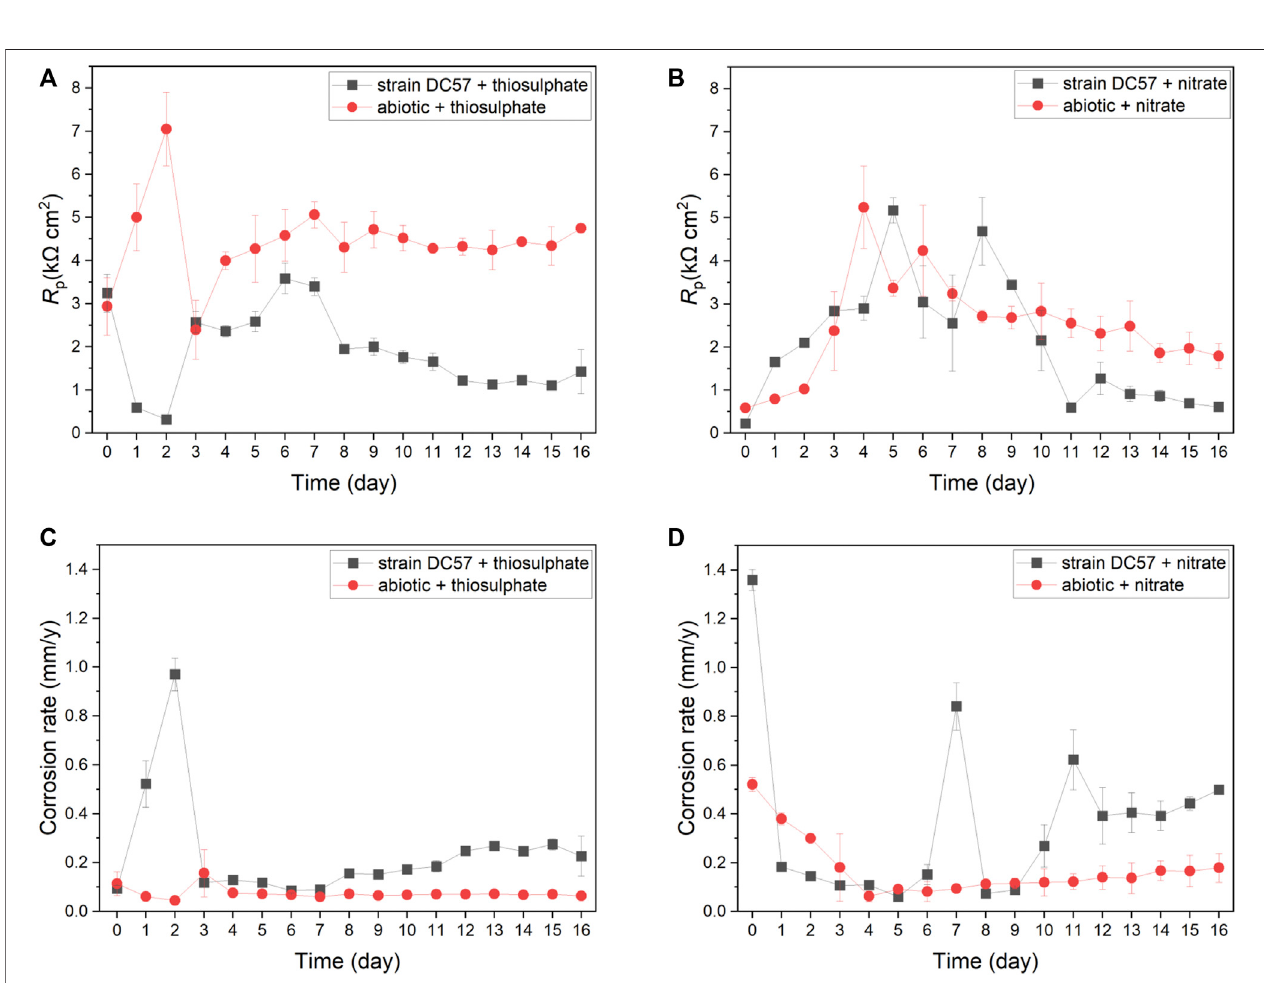
FIGURE 2 | Variation of R p (A,B) and corrosion rate (C,D) vs. time during 16-days exposure to thiosulphate (A,C) and nitrate (B,D) reducing conditions.